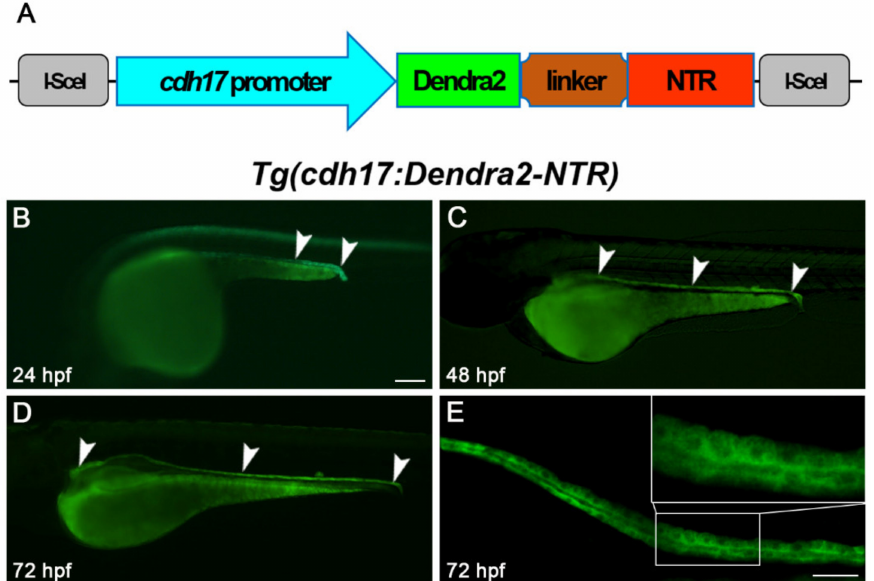
Figure 1. Tg(cdh17:Dendra2-NTR) transgenic line construction. ( A ) Constructs used to generate the cdh17 -driven Dendra2 - NTR transgenic line is shown. Dendra2, green-to-red photo-switchable fluorescent protein; NTR, nitroreductase. Dendra2 expression in Tg(cdh17:Dendra2-NTR) transgenic fish renal tubules (arrowheads) at 24 hpf ( B ), 48 hpf ( C ) and 72 hpf ( D ), respectively. Scare bar: 200 µ m. ( E ) Detailed display of the laser confocal image in the middle section of the 72 hpf Tg(cdh17:Dendra2- NTR) transgenic fish renal tubule. Scare bar: 100 µ